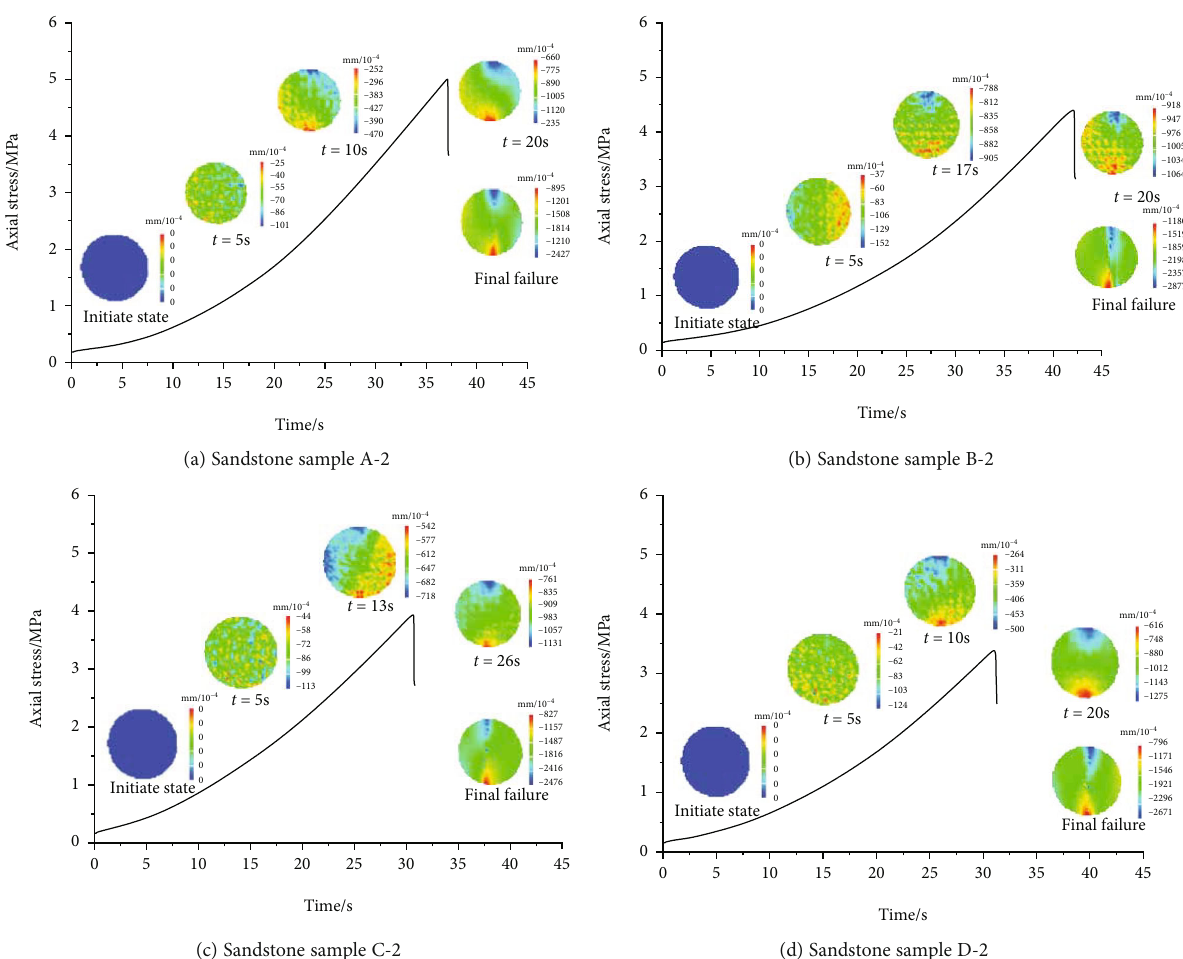
Figure 9: Sandstone sample deformation evolution